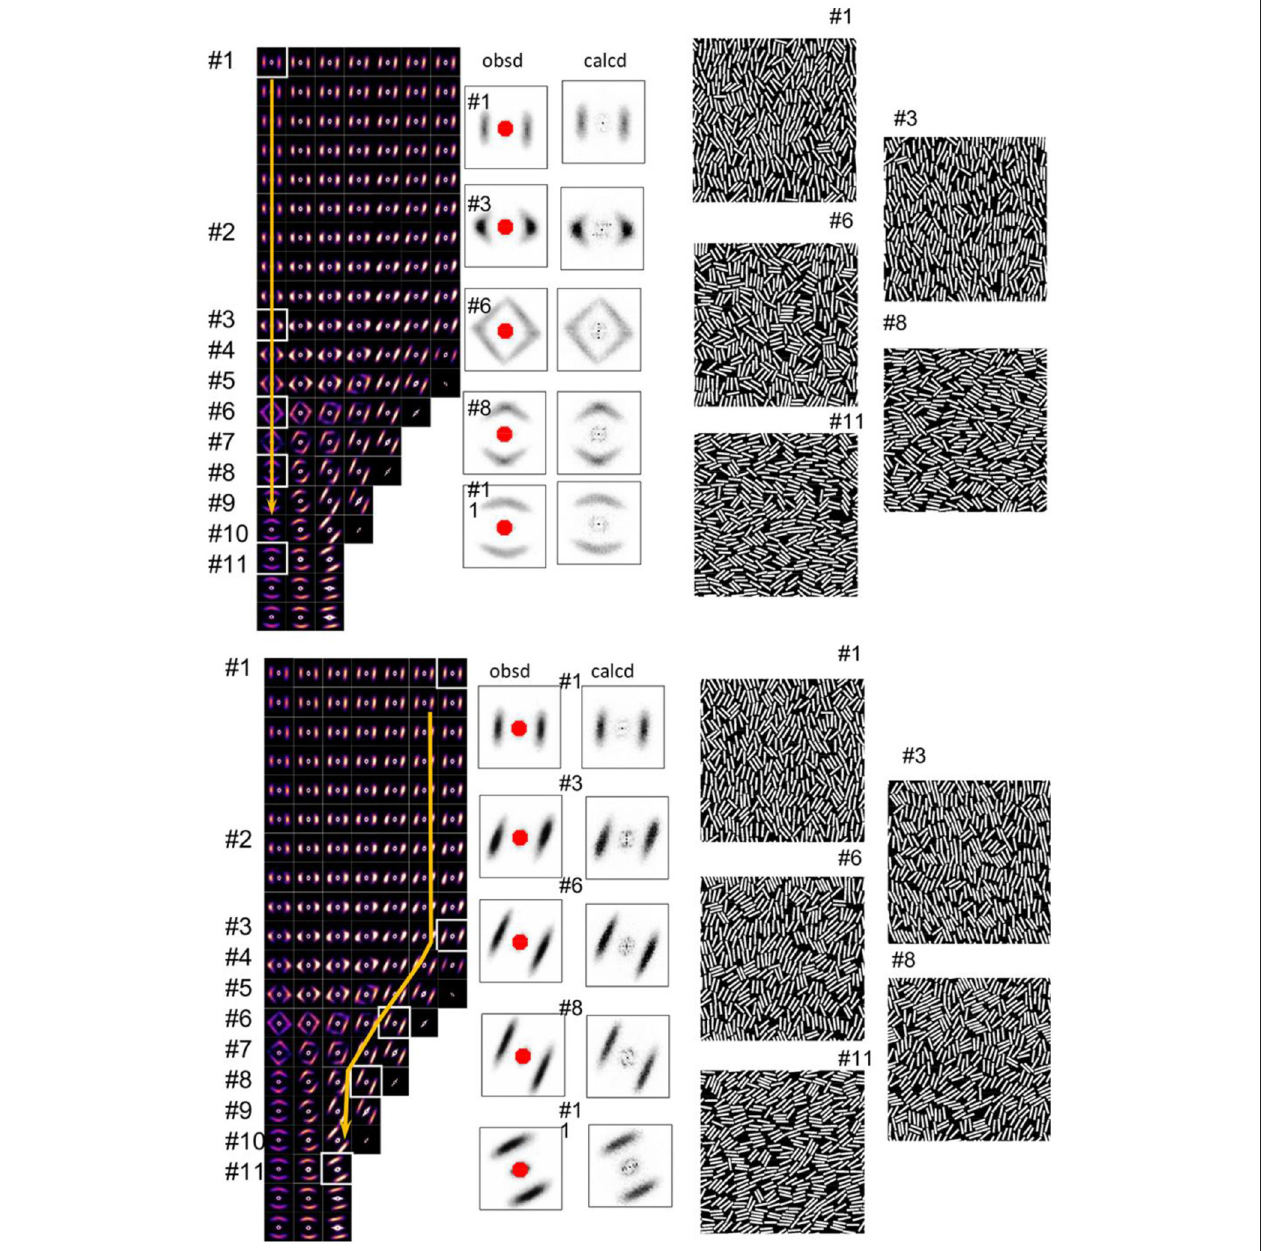
FIGURE 13 | Stacked lamellar models proposed [134] on the basis of information extracted from the Monte Carlo simulations of observed SAXS patterns of a biaxially oriented LLDPE (linear low density polyethylene) sample. Different sets of data are shown corresponding to SAXS patterns measured at different positions in the sample. Also shown is the comparison between experimentally observed and Monte Carlo simulated SAXS patterns. Reprinted (adapted) with permission from Tahara et al. [134]. Copyright (2020) American Chemical